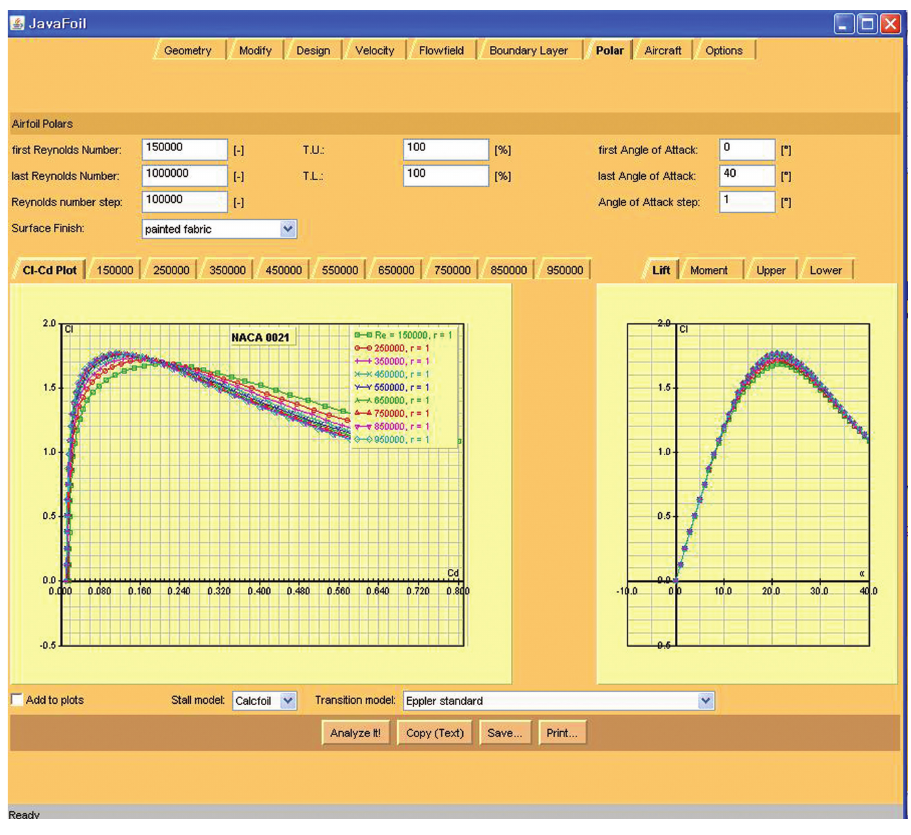
Figure 4 Parametric case study results with solidity, airfoil, blade number and height to radius